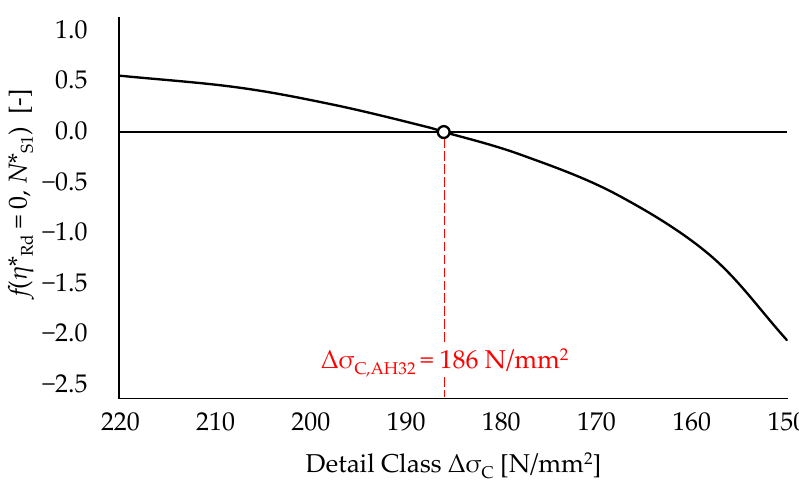
Figure 8. Trend of f ( η * Rd = 0, N * S 1 ) for decreasing values of Δ σ C,AH32 (Specimen S1 ). One can notice that iterative solution of Equation (8) for null corrosion yields an “equiv- alent” detail class for AH32 pristine coupons ∆ σ C,AH32 = 186 N/mm 2 . Notably, this value is only slightly higher (+3.3%) than the detail class provided by [3] for plain steel members subjected to normal stresses (i.e., ∆ σ C = 180 N/mm 2 ). Hence, the related values of VLCF limit and CAFL are equal to ∆ σ 10000, AH32 = 506 N/mm 2 and ∆ σ D,AH32 = 155 N/mm 2 , respectively. With regard to the corroded specimens S2 -to- S4 , the trends of f ( η , N i *) and the esti- mated critical corrosion degrees for each test are summarized in Figure 9 and Table 3, respectively. The values of η * Rd are also compared with corresponding the values of η max reported in [24].